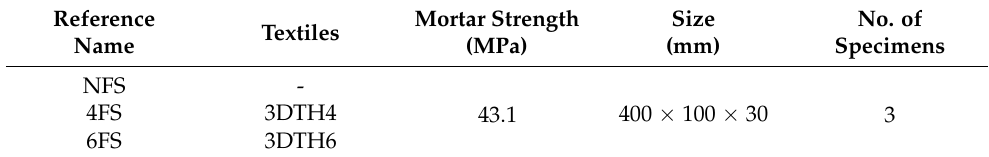
Table 2. Flexural test of 3D-TRM